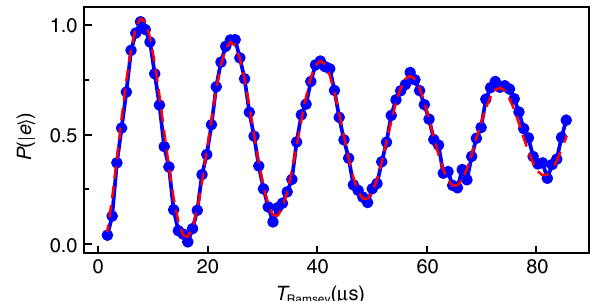
FIG. 9. Ramsey experiment at the flux-frustration point. The T (cid:3) 2 obtained by fitting the decay to an exponential is 71 . 3 μ 0 . 35 Φ 0 . The total Purcell relaxation rate for a bath temper- ature of 60 mK corresponds the dotted blue curve in Fig. 3(a) of the main text.